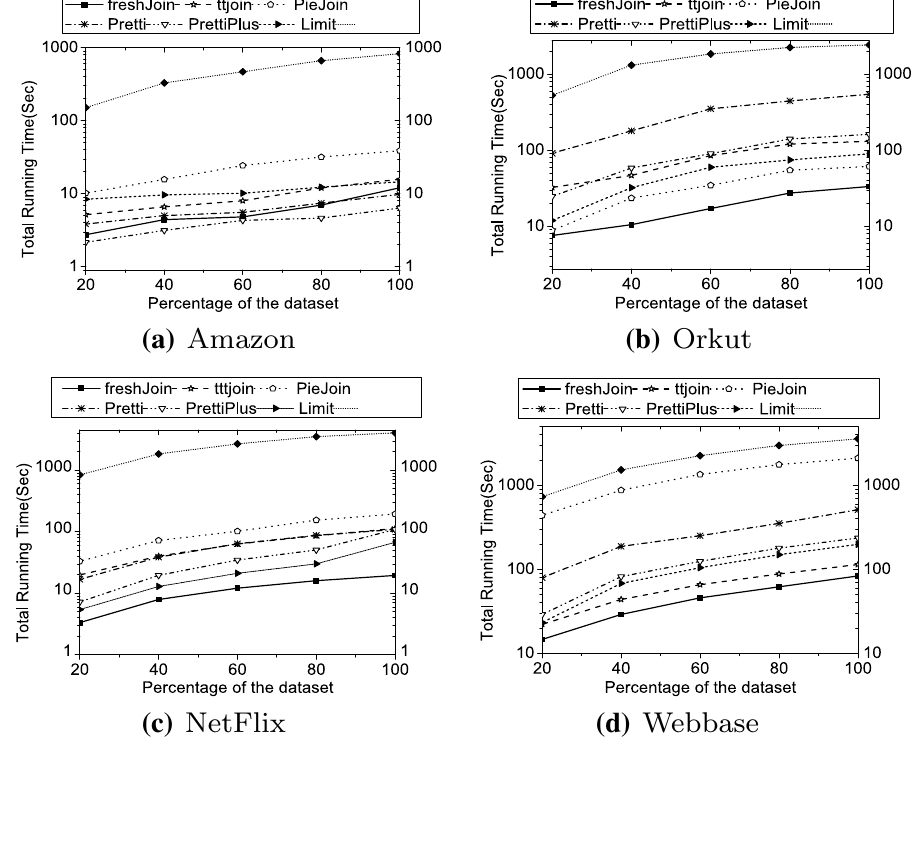
Fig. 9 Scalability in